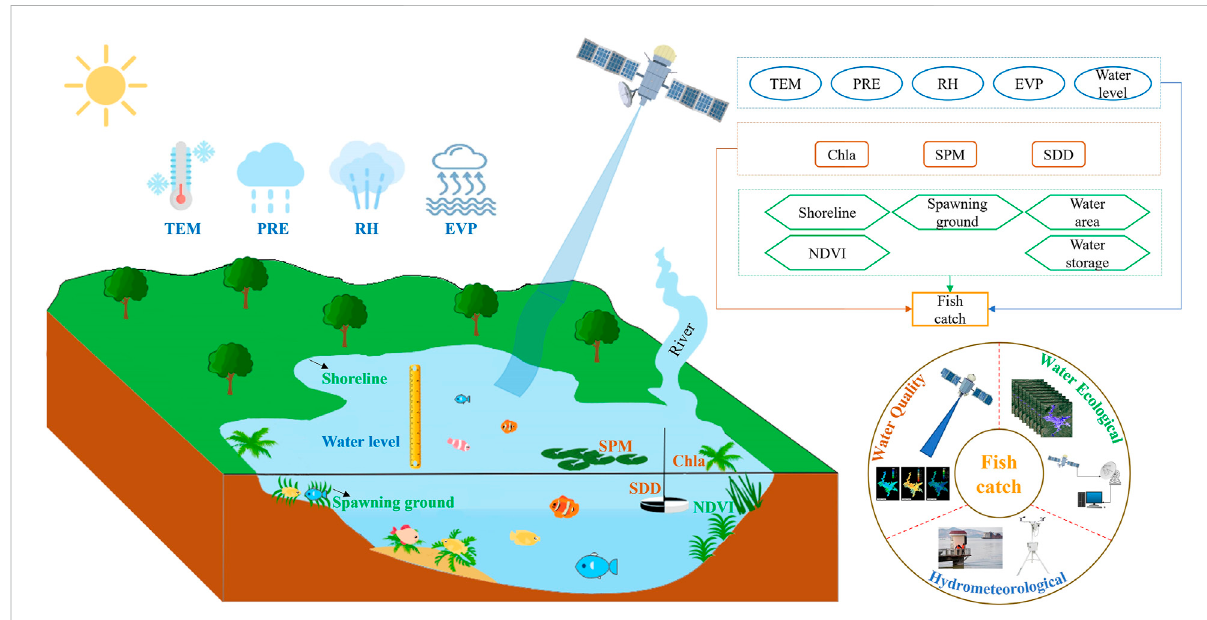
FIGURE 2 Schematicdiagramillustratingthemachinelearningmodelof fi shcatchsimulationandmainenvironmentalvariables.Variablesassociatedwith hydrometeorological conditions are in oval blue boxes. Variables associated with water quality are in brown-rounded rectangular boxes. Variables associated with water ecological conditions are in green-hexagon